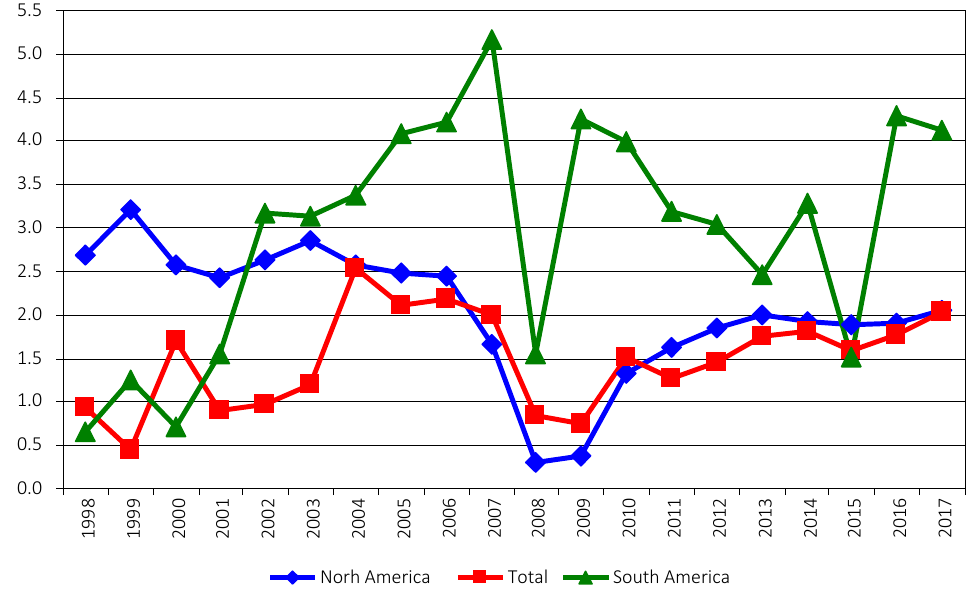
Figure 6. Financial stability index of banking systems of the World, North America, and South Table 5. Risk map of financial stability of geo-banking systems in 1998–2017